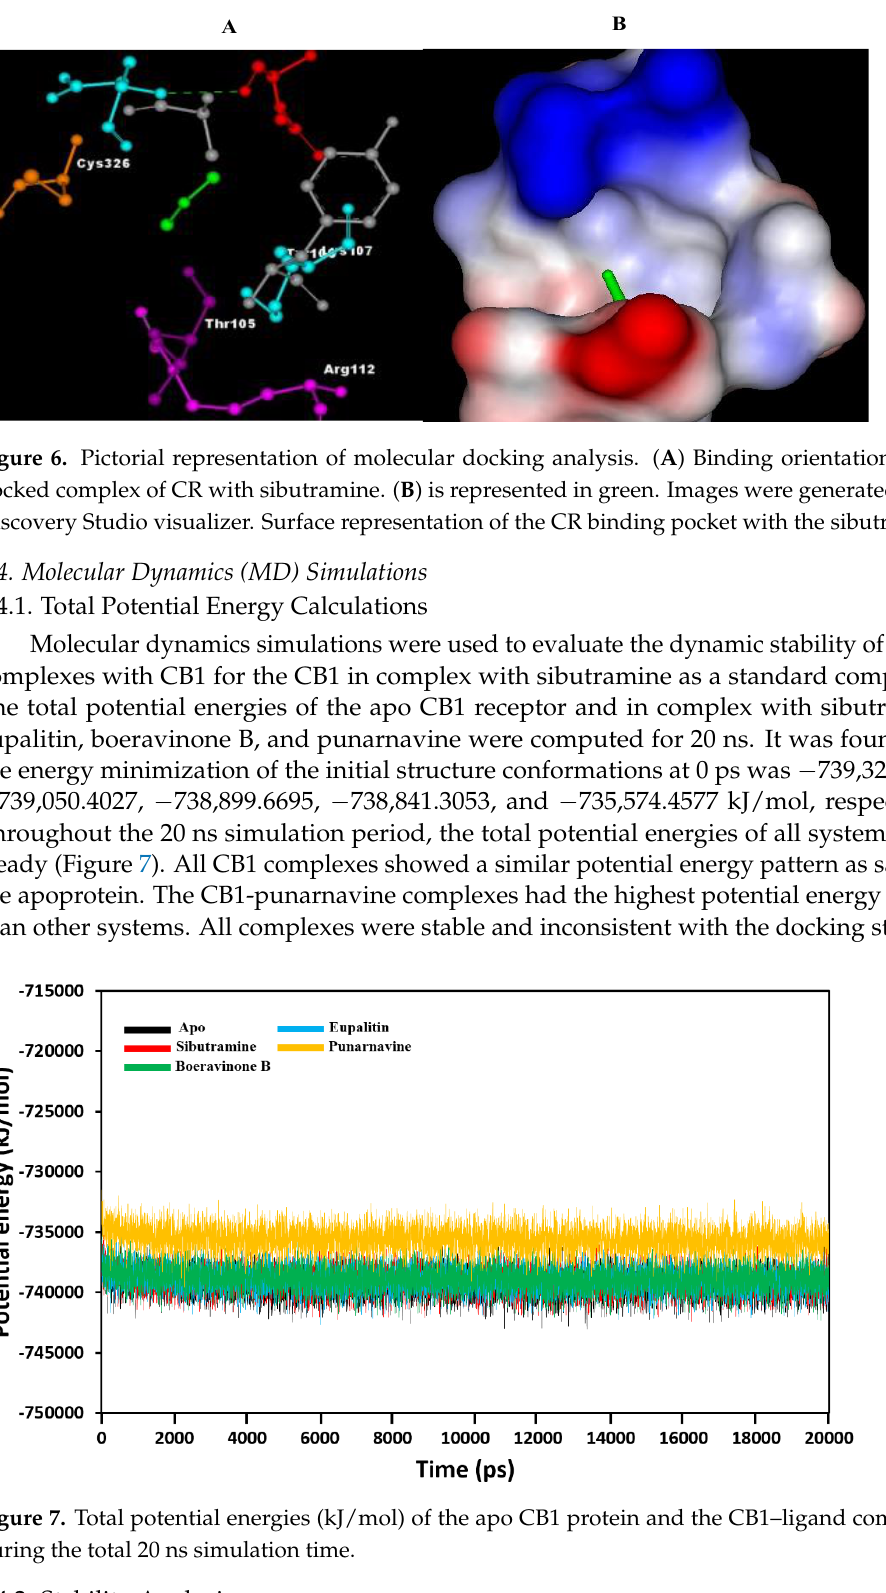
Images were generated using Discovery Studio visualizer.